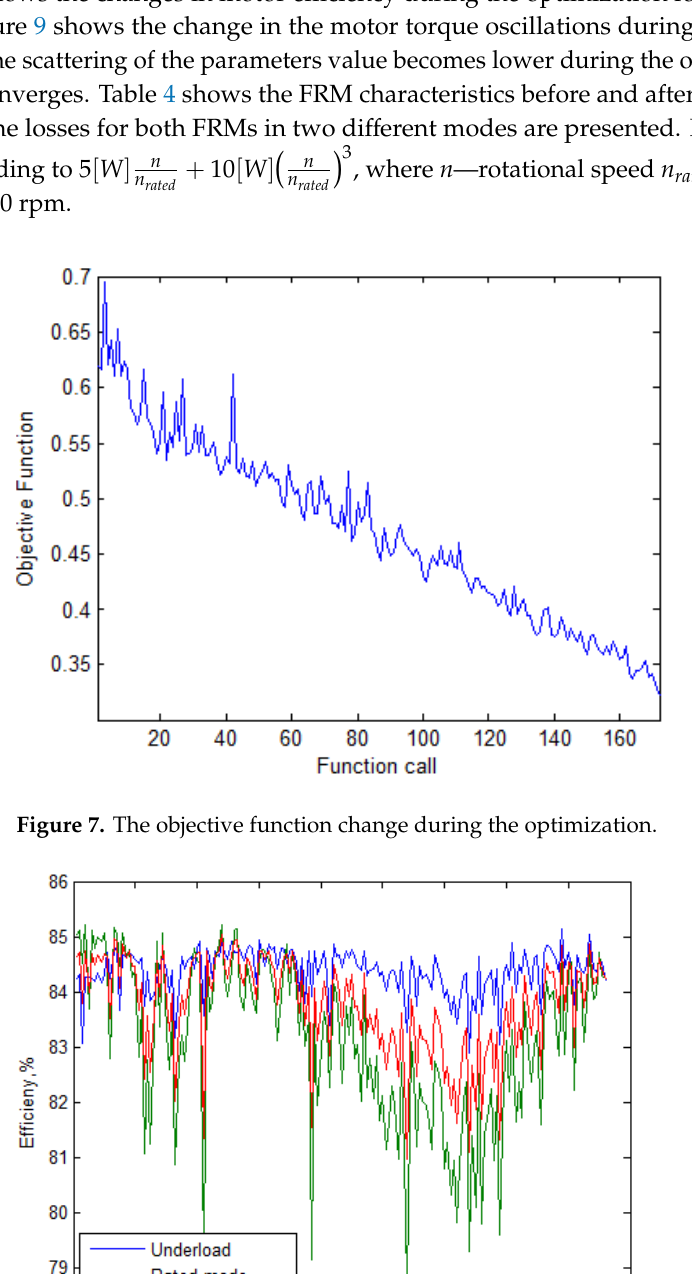
Figure 9. Change of the motor torque oscillations during the optimization. Table 4. The FRM characteristics before and after the optimization.